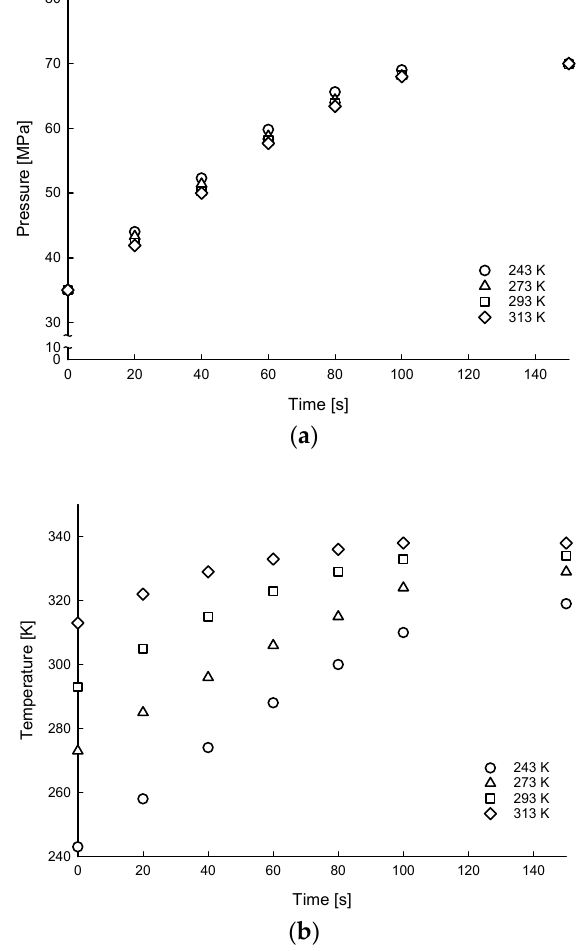
Figure 8. Time histories of hydrogen of average gas pressure ( a ) and temperature ( b ) distributions of filling process for 35 MPa SOC pressure condition under different ambient temperature conditions. Table 4. Results of CGH 2 filling